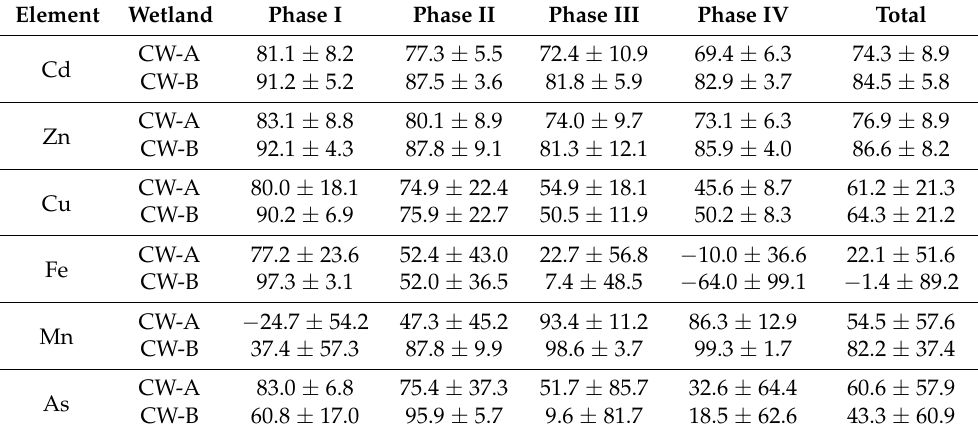
Table 1. Mass removal (%) for heavy metals from NMD by the